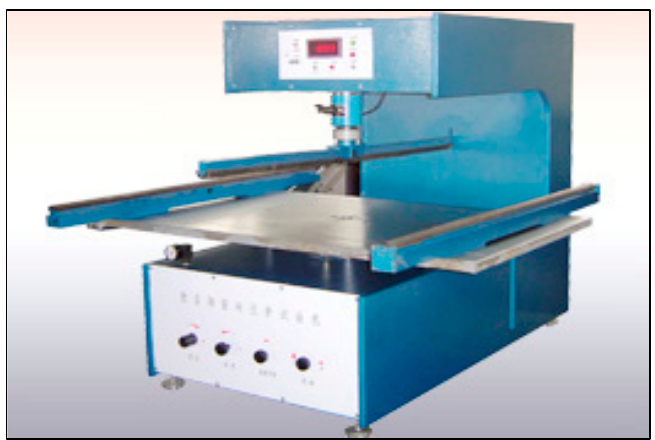
Figure 5. TZS-type digital flexural testing machine.